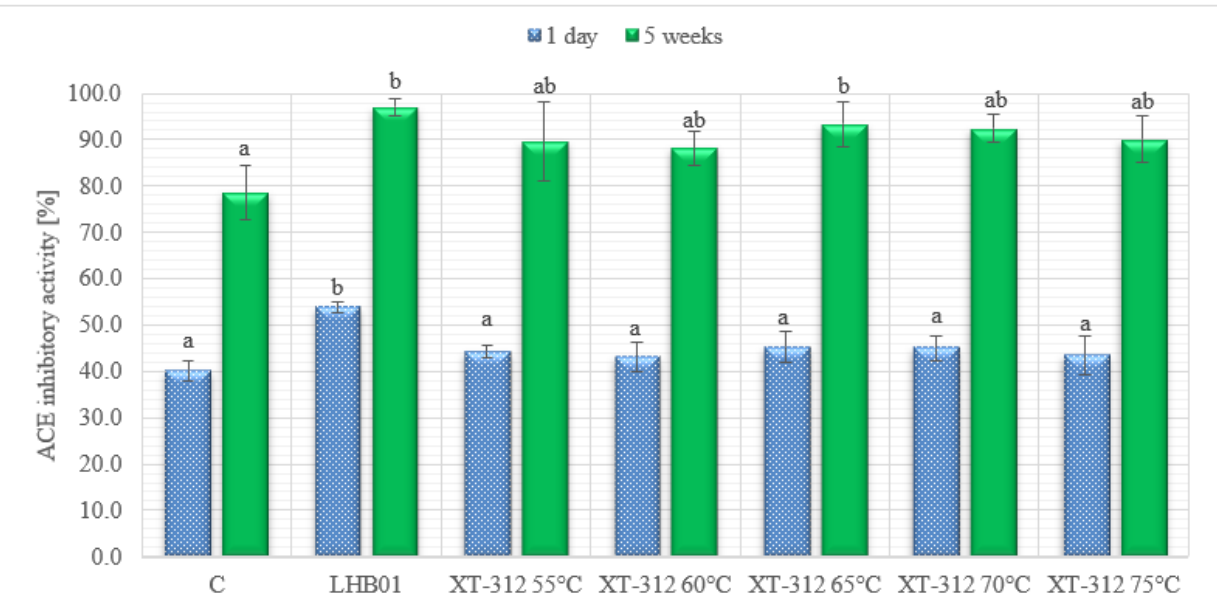
Figure 2. ACE inhibitory activity (%) of the experimental cheese models during ripening (mean values and standard deviations, a,b homogenous groups, p < 0.05, n = 6).